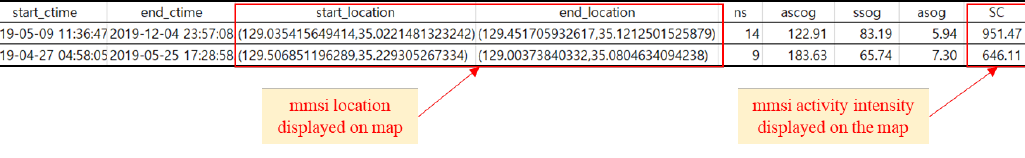
Figure 11. Calculation result of cluster strength by MMSI.